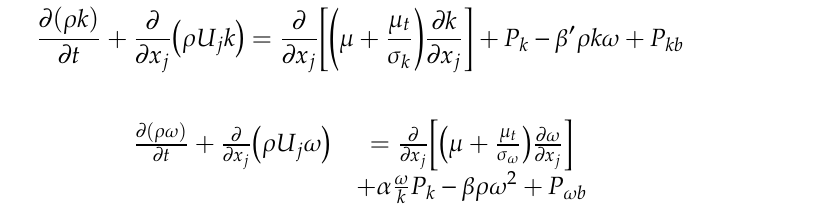
Figure 3. Grid diagram and the centrifugal pump with vanes.